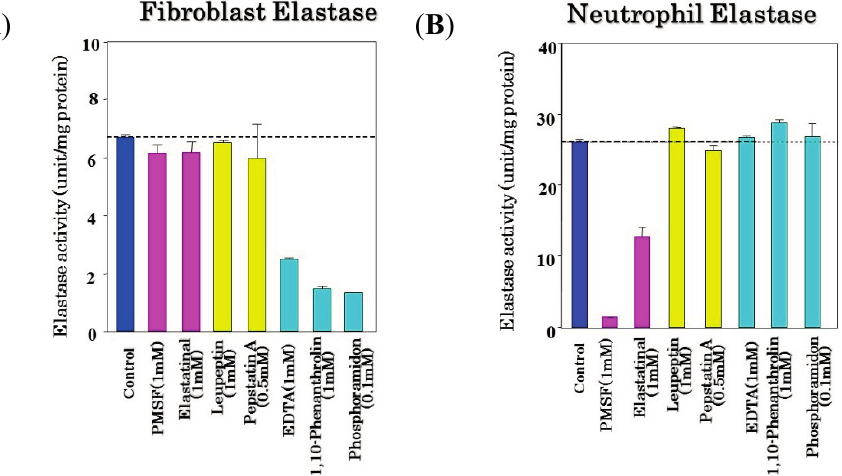
Figure 7. Inhibitory profiles of fibroblast elastase ( A ) and neutrophil elastase ( B ). To measure fibroblast elastase, an enzyme solution obtained from a lysate of human fibroblasts was used at a concentration of 100 μ g/mL. Neutrophil elastase was used at a concentration of 20 U/mL. Elastase activity was measured using STANA as a substrate in the presence of various inhibitors. Data represent means ±